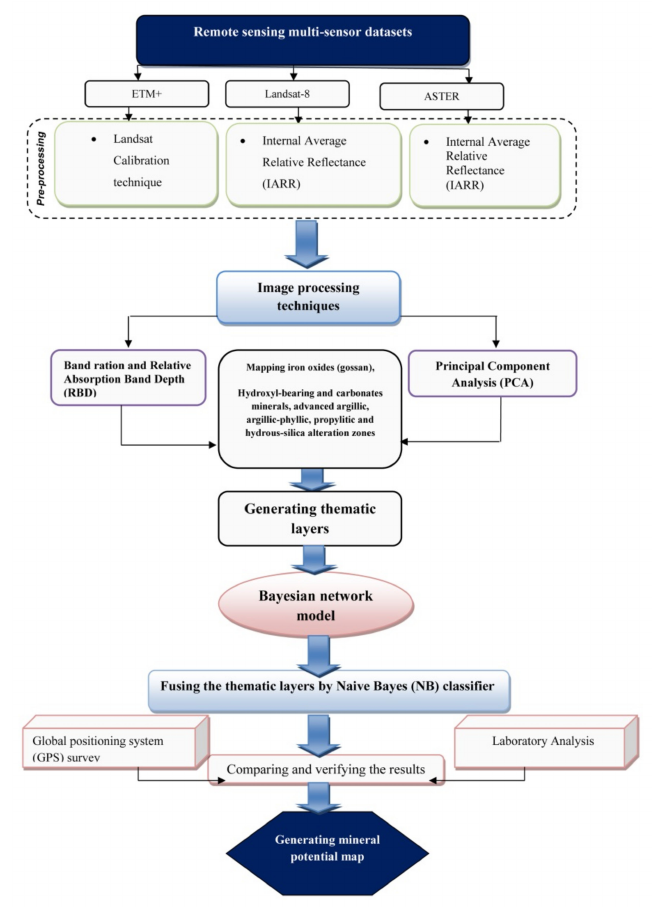
Figure 2. An overview of the methodological flowchart applied in this